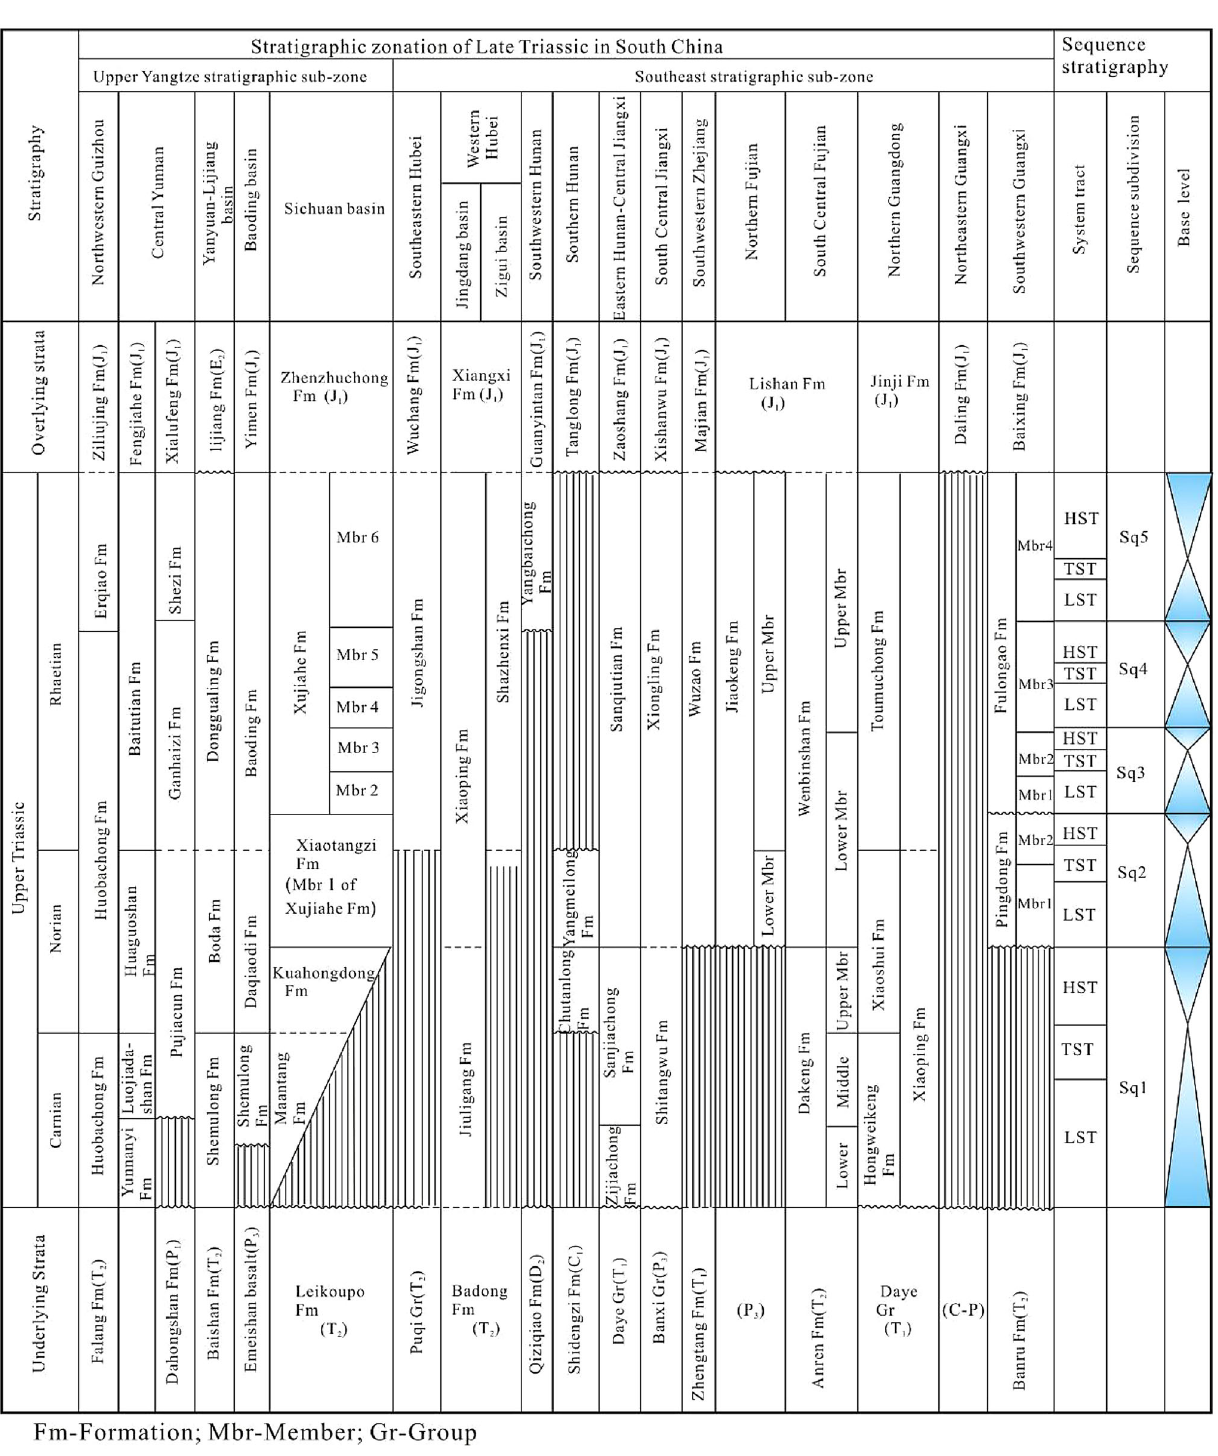
Sequence stratigraphy, paleogeography, and coal accumulation regularity of major